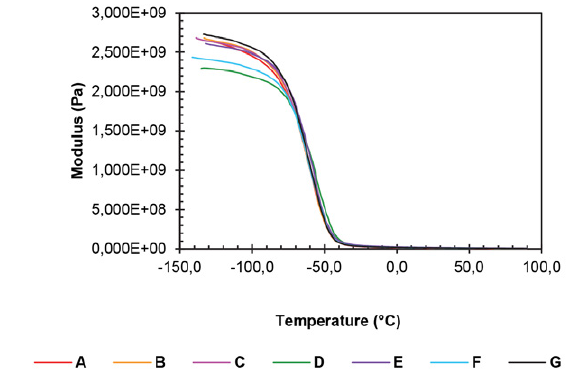
Figure 2. Storage modulus (E ’ ) versus temperature curves of rubber samples containing various processing aid